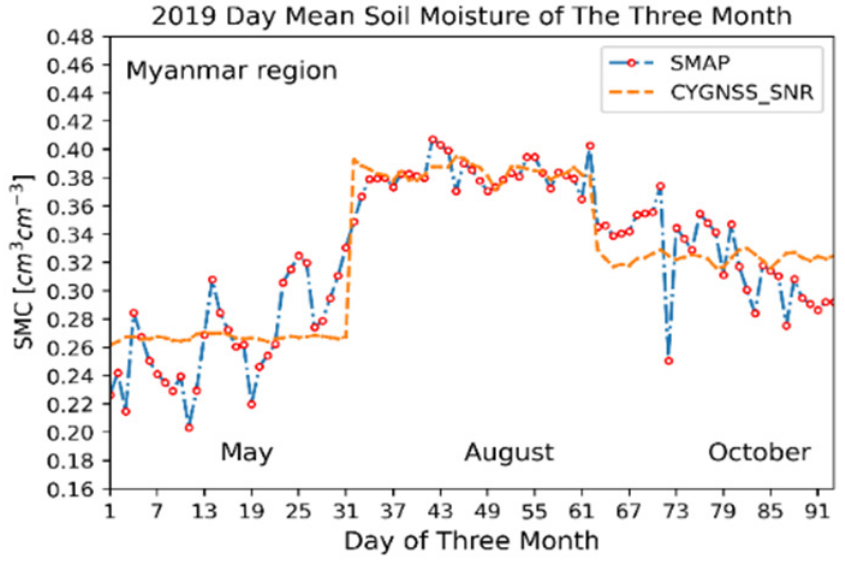
Figure 9. DDM SNR and SMAP diurnal mean SM in May, August, and October